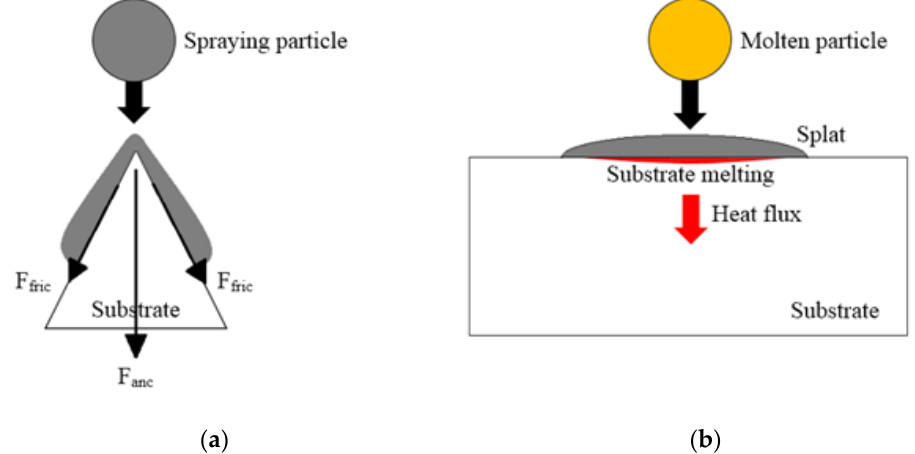
Figure 1. Schematic of bonding mechanism of thermal sprayed coating: ( a ) mechanical anchor, ( b ) metallurgical bonding.